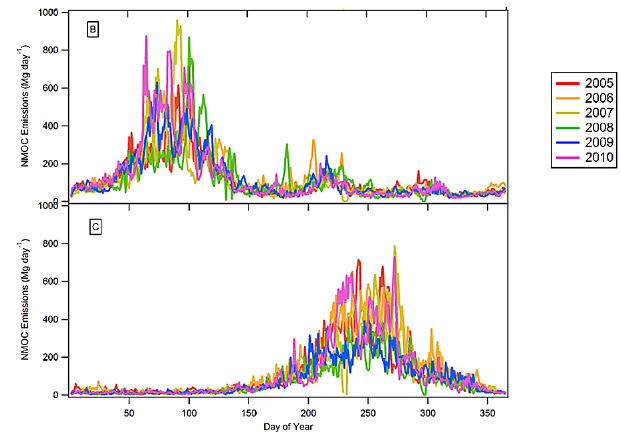
Figure 16. Daily emissions of NMVOC from fires for 2005 through 2010 for the Northern Hemisphere (top) and Southern Hemisphere (bottom) as represented in the FINN data set (Wiedinmyer et al.,